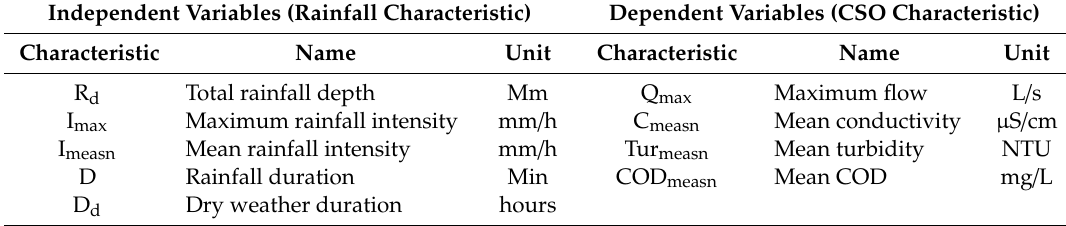
Table 1. Definition of the dependent variables (CSO characteristics) and independent variables (rainfall characteristics) for the canonical correlation analysis (CCA) and the partial least squares regression model